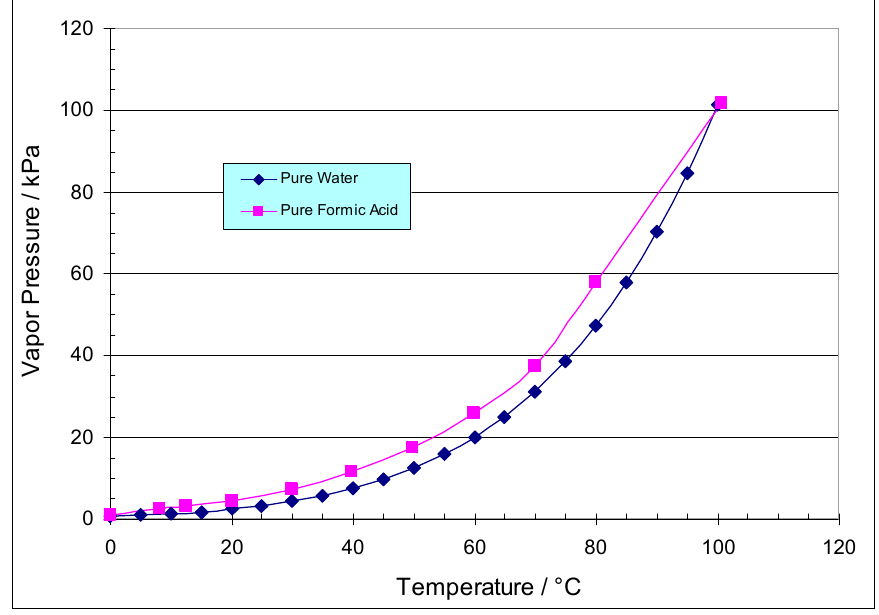
Figure 8. Comparison of pure FA and pure water component vapor pressures versus temperature.